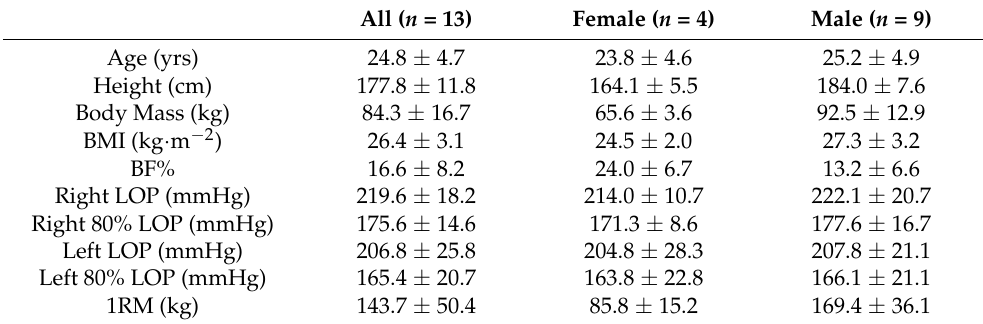
Table 1. Descriptive characteristics of study